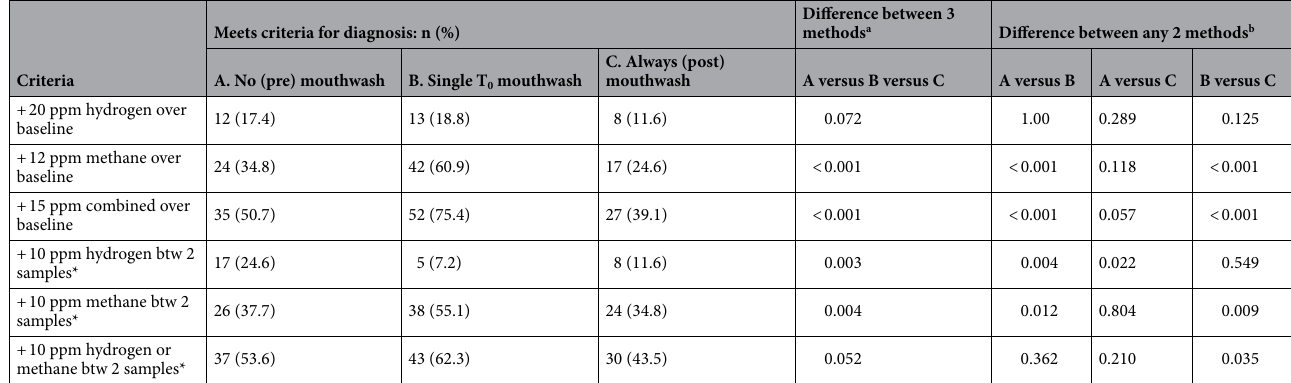
Table 6. Subjects meeting diagnostic criteria within 80 min depending on oral hygiene in 69 tests. a Cochran’s